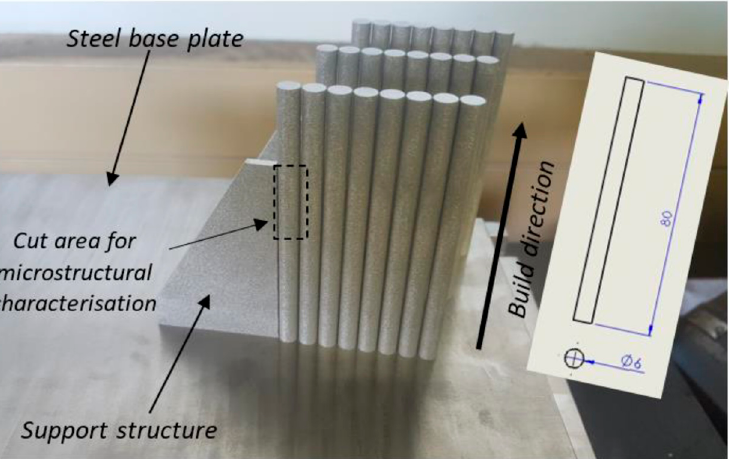
Figure 2. A photograph showing produced cylindrical rods on the EOSINT M280 machine table. The specification of each of these rods in millimetres is shown by the insert schematic drawing.